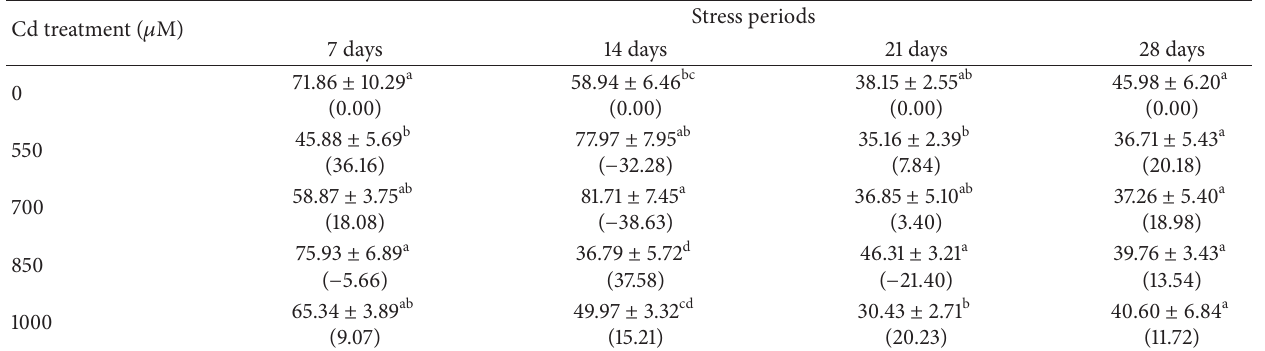
Table 6: H O ( 𝜇 Mg − 1 FW) of cotton callus culture (cv. YZ1) grown under various levels of 2 2